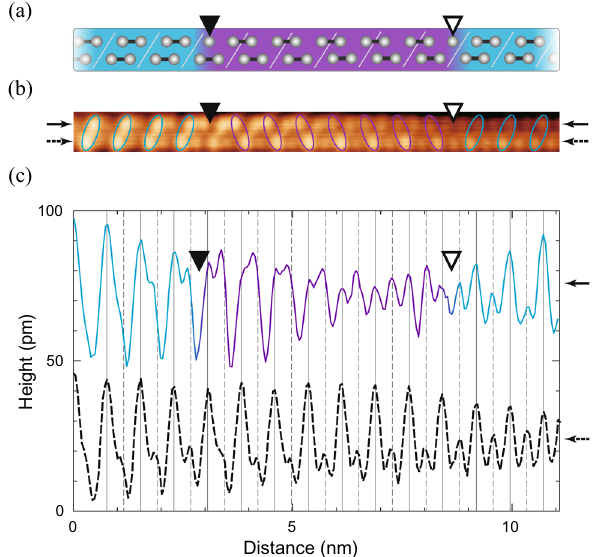
Figure 4. Experimental evidence of a pair creation of RC- and LC-solitons. ( a ) Atomic model of a pair of RC- and LC-solitons. ( b ) Scanning tunneling microscopy (STM) image showing a pair of RC- and LC-solitons. ( c ) STM line profiles taken from the STM image in ( b ). Solid and dashed profiles are taken at the upper and lower chains indicated by solid and dashed arrows in ( b ), respectively. The line profiles are high-pass filtered to get rid of slowly varying backgrounds. The distance between adjacent vertical solid and dashed lines is half the length of unit cell, a 0 2 . In this figure, closed and open triangles indicate the kink positions of RC- and LC-solitons,